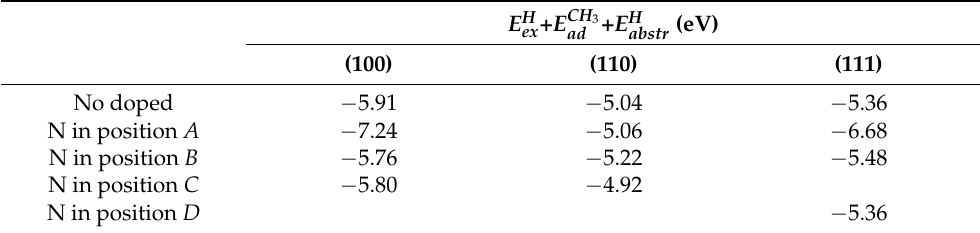
, and hydrogen ad abstr